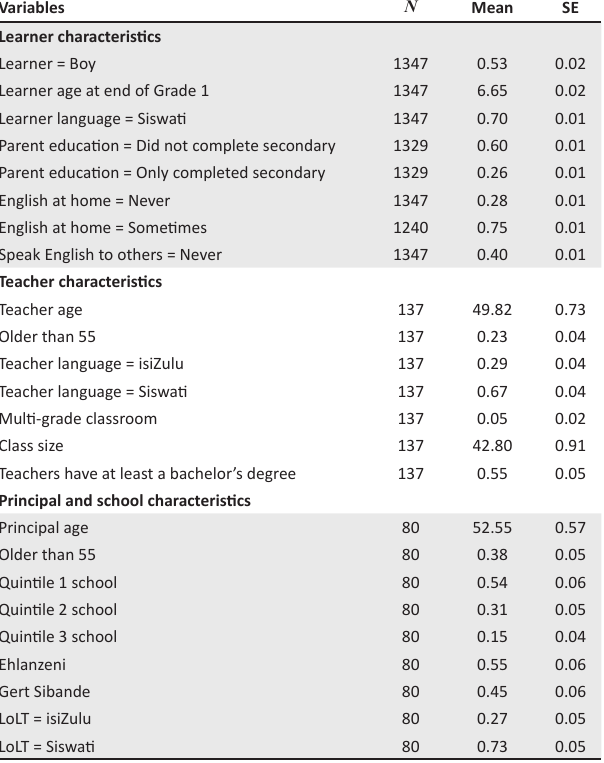
TABLE 2: Subtasks contained in the instruments at each time point. Construct